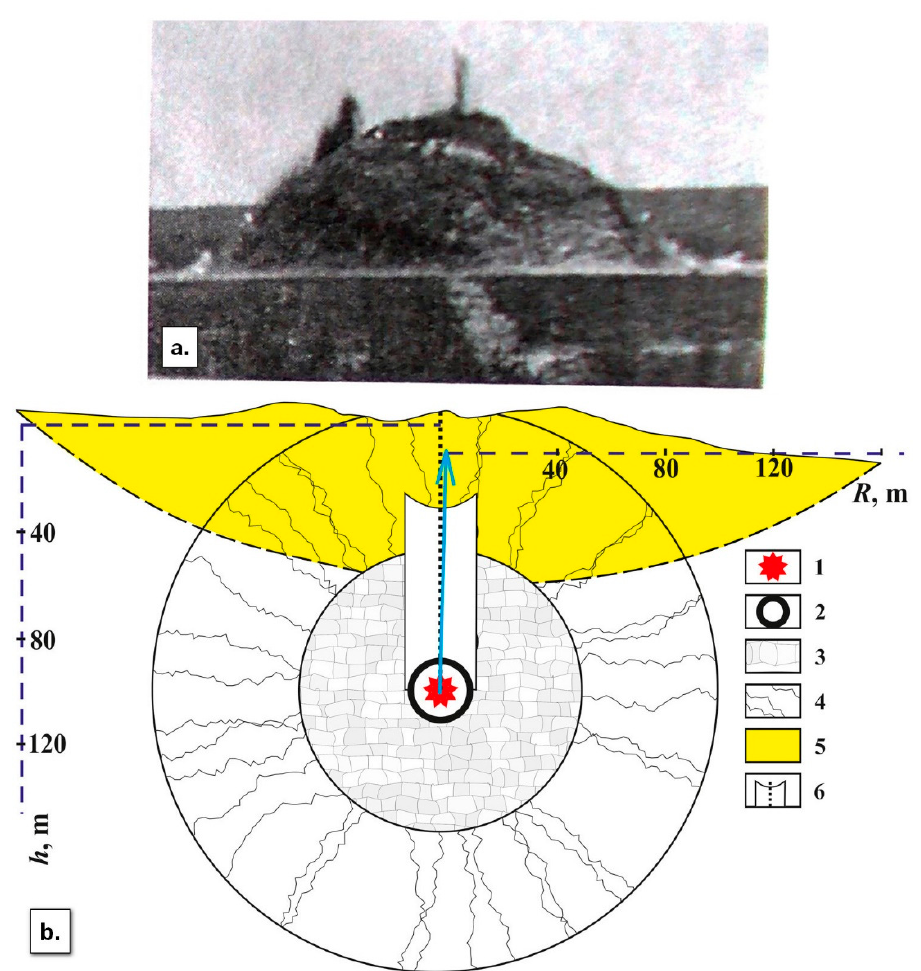
Figure 2. ( a ): Snapshot of the PUNE Crystal site about 3.5 s after detonation, when the upthrust dome reached its maximum height of ~60 m, at a base width of 200 m (the PUNE Crystal filming was conducted from a location situated south–south-west of the explosion epicenter [1]). ( b ): Sketch of the confinement cavity with crushed and cracked zones around. (1) Shot point; (2) confinement cavity with a hardpan of molten rock; (3) crushed zone; (4) cracked zone; (5) spalled zone, with contours of the dome-shaped mound, according to the field topographic surveys; (6) chimney (dashed line in the middle is the emplacement hole). Arrow shows the direction of shock pressure wave.